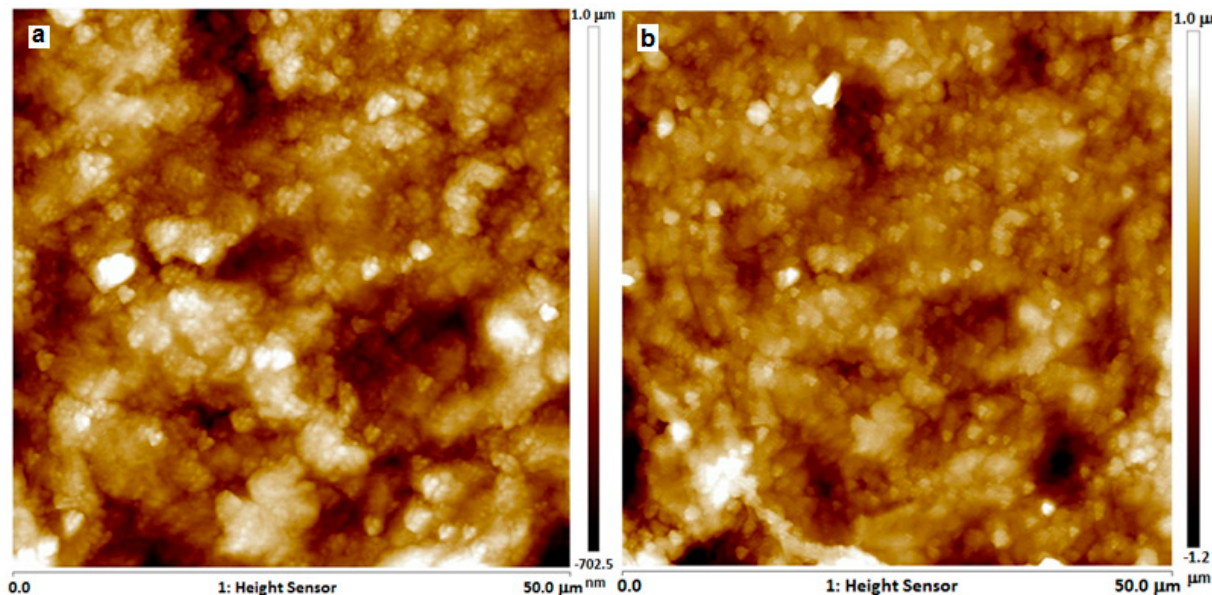
Figure 7. 2D images of mild steel: ( a ) 1 M HCl; ( b ) 1 M HCl with 600 ppm of inhibitor.